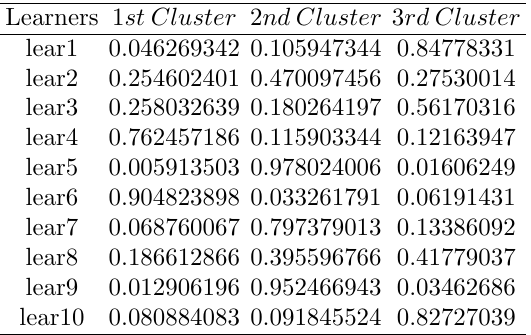
Table 2. Degree of membership